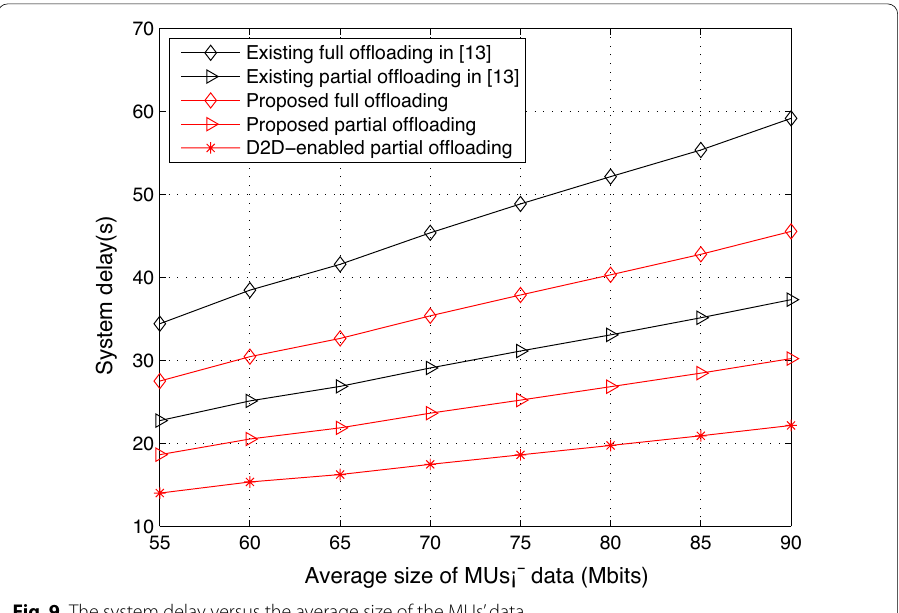
Fig. 9 The system delay versus the average size of the MUs’